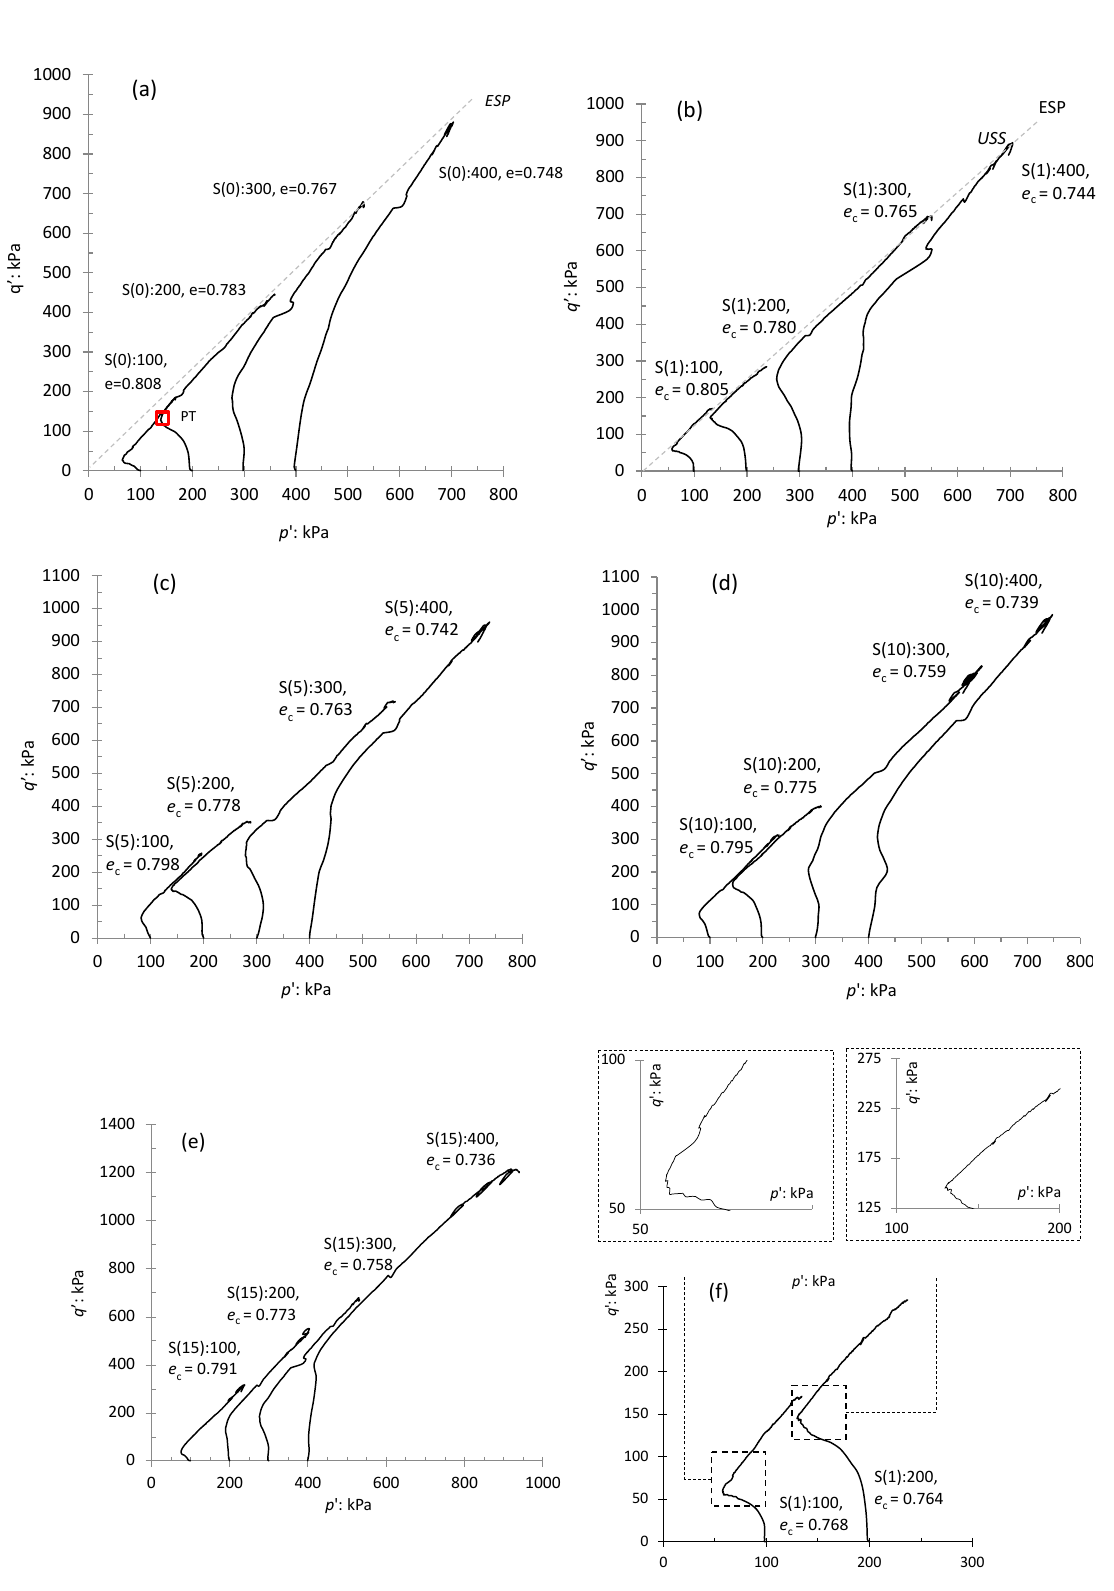
Figure 6. Stress path following undrained shear behavior: ( a ) base sand; ( b ) 1% NS; ( c ) 5% NS; ( d ) 10% NS; ( e ) 15% NS; ( f ) perturbations for 1% NS.